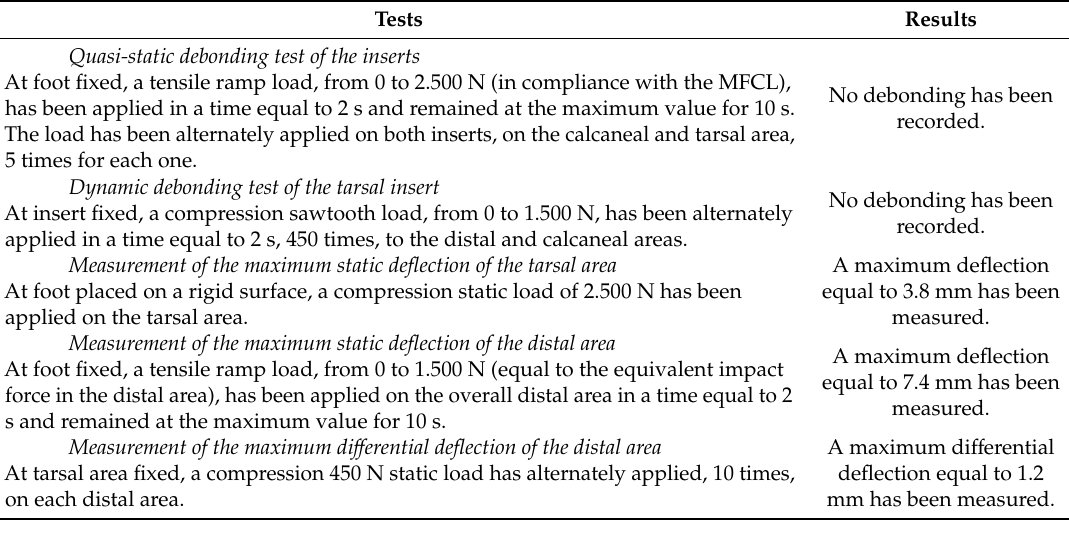
Table 5. Tests for the foot prototype made of carbon fiber.